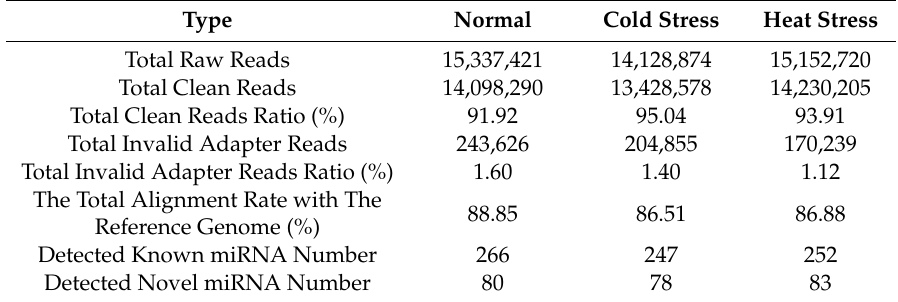
Table 2. Statistics of small RNA sequences from broiler’s spleens.